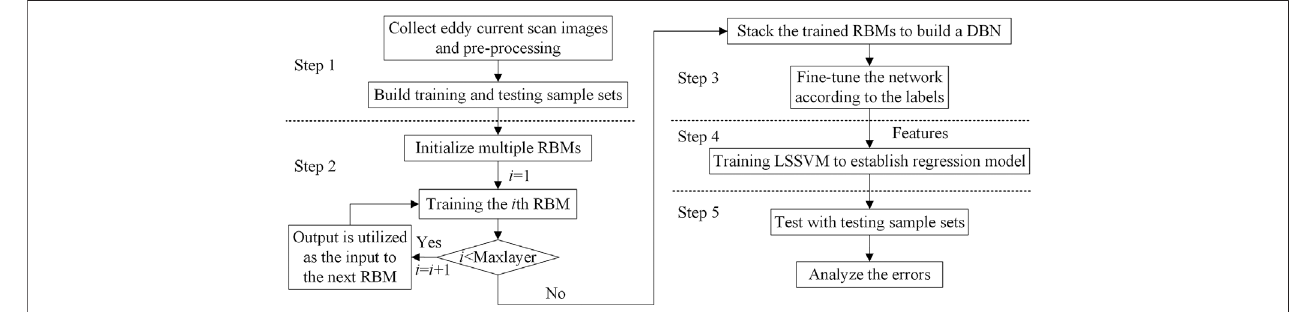
FIGURE 3 | Flowchart of the proposed method.